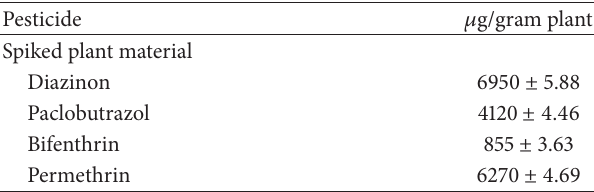
Table 2: Spiked plant material extractions. Pesticide 𝜇 g/gram plant